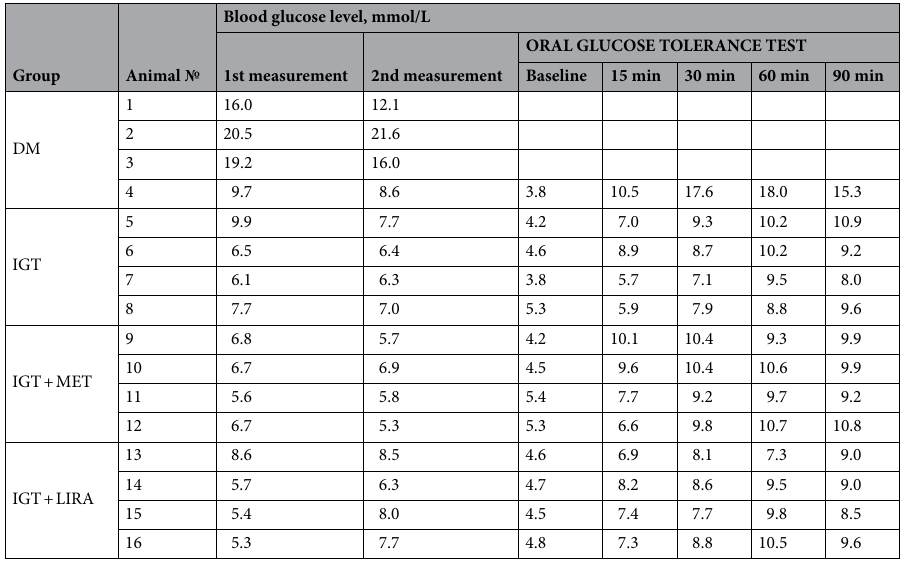
Table 1. Blood glucose measurement for DM and IGT